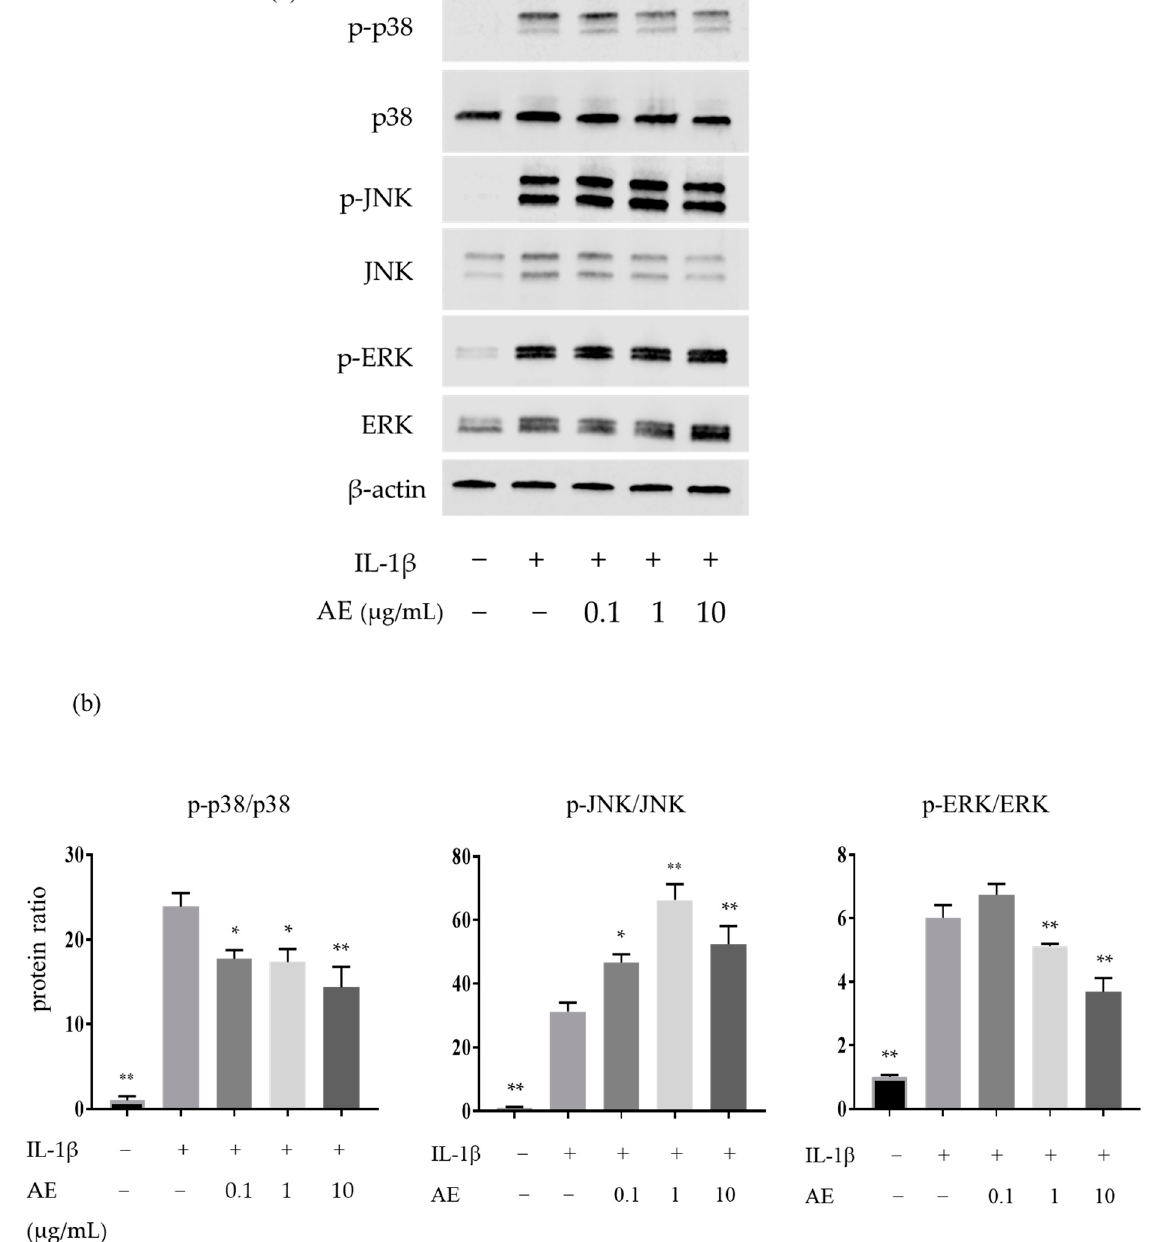
Figure 2. Western blot analysis of proteins involved in the MAPK pathway in NHCs. ( a ) Representative Western blots of total and phosphorylated MAPK family proteins. ( b ) Quantification of phosphorylated p38, JNK, and ERK. Statistical significance: Tukey’s multiple comparisons test * p < 0.05, ** p < 0.01 compared to IL-1 β stimulation without AE.